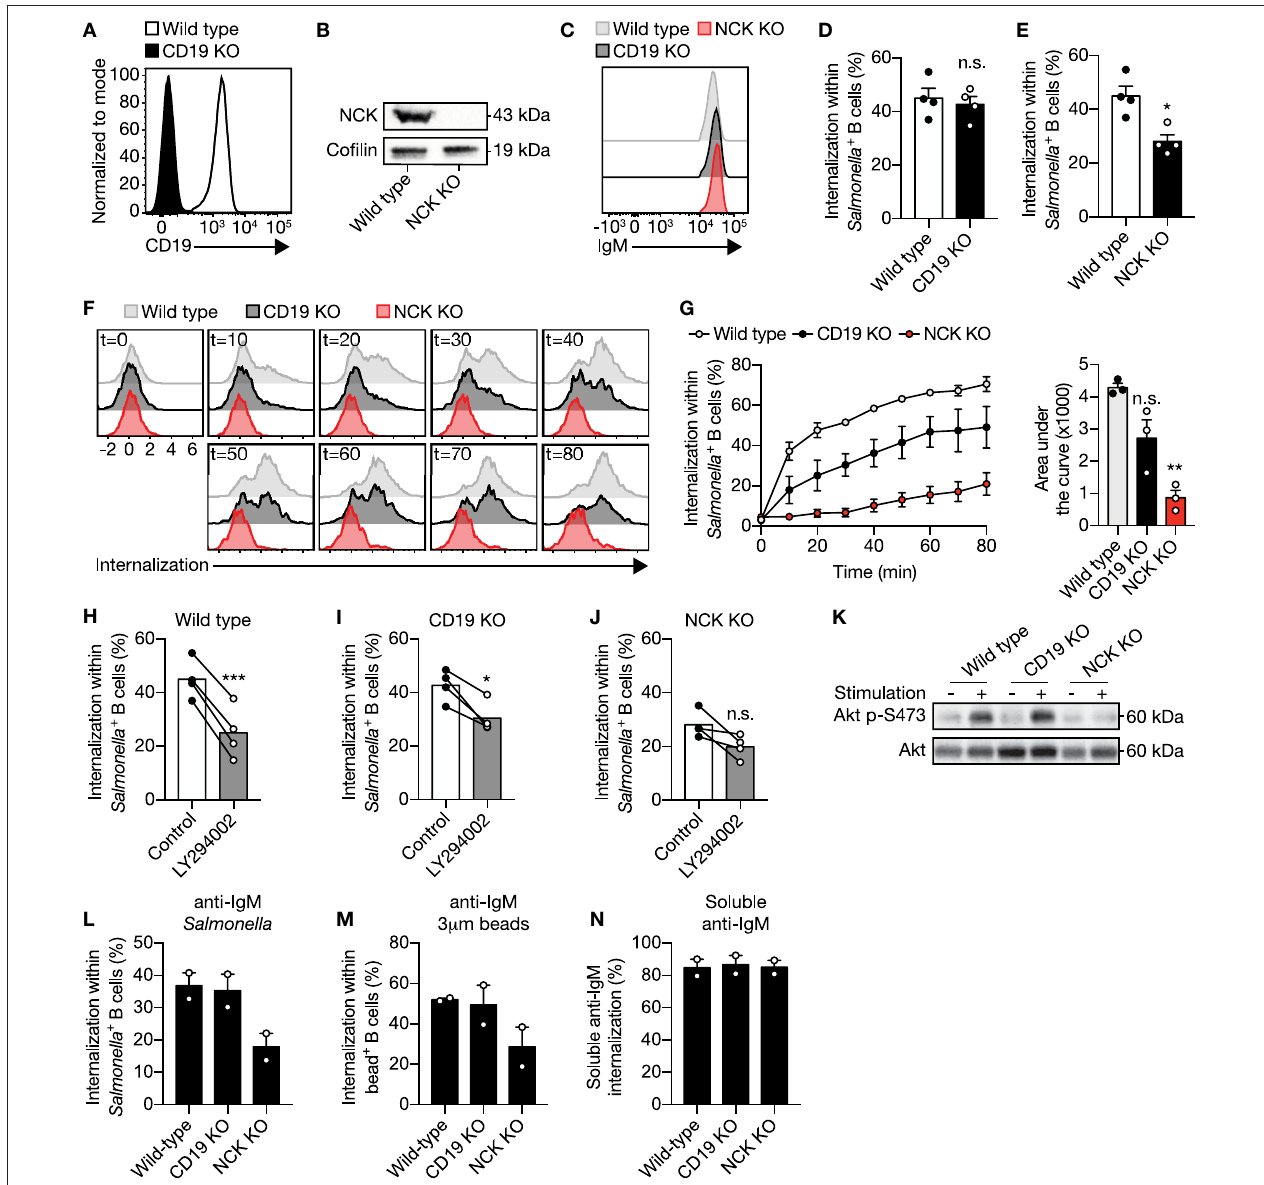
FIGURE 3 | The adaptor protein NCK is required for PI3K activity to facilitate IgM-BCR-induced internalization of large particles. (A) Representative histogram of CD19 expression in wild type and CD19 KO Ramos B cells. (B) Immunoblot of whole cell extracts from wild type and NCK KO Ramos B cells probed with NCK- or cofilin-specific (loading control) antibodies. (C) Representative histogram of surface IgM expression in wild type, CD19 KO and NCK KO Ramos B cells. (D,E) Proportion of internalization within S. typhimurium + CD19 KO (D) and NCK KO (E) Ramos B cells compared with wild type ( n = 4). (F,G) Representative histograms (F) and quantification [ (G) ; left] of the proportion of internalization within S. typhimurium + wild type, CD19 KO and NCK KO Ramos B cells in time ( n = 3). The area under the curve was obtained to quantify internalization in time [ (G) ; right]. (H–J) Proportion of internalization within S. typhimurium + wild type (H) , CD19 KO (I) and NCK KO (J) Ramos B cells after treatment with a PI3K inhibitor ( n = 4). (K) Immunoblot of whole cell extracts from wild type, CD19 KO and NCK KO Ramos B cells that were unstimulated ( − ) or stimulated ( + ) with S. typhimurium. The blots were probed with specific antibodies against pAKT at S473 and AKT. (L,M) Proportion of